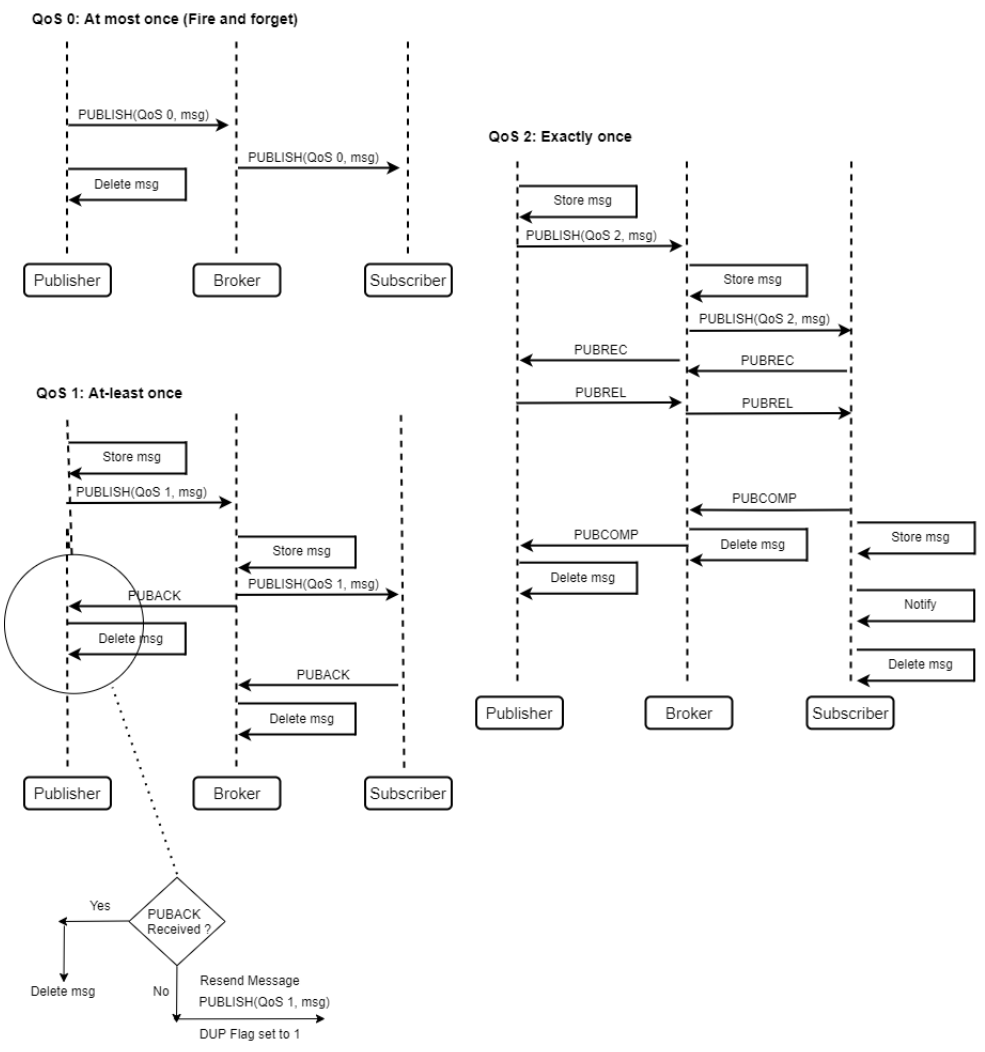
Figure 4. Different QoS